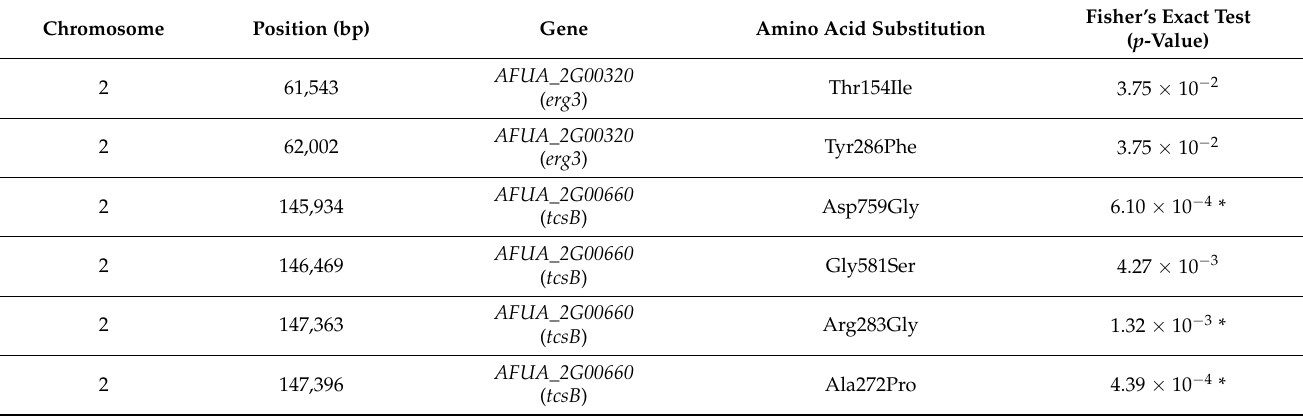
Table 4. Fisher’s exact tests comparing AMB resistant and susceptible strains on the 12 previously found missense variants associated with AMB resistance ( n =